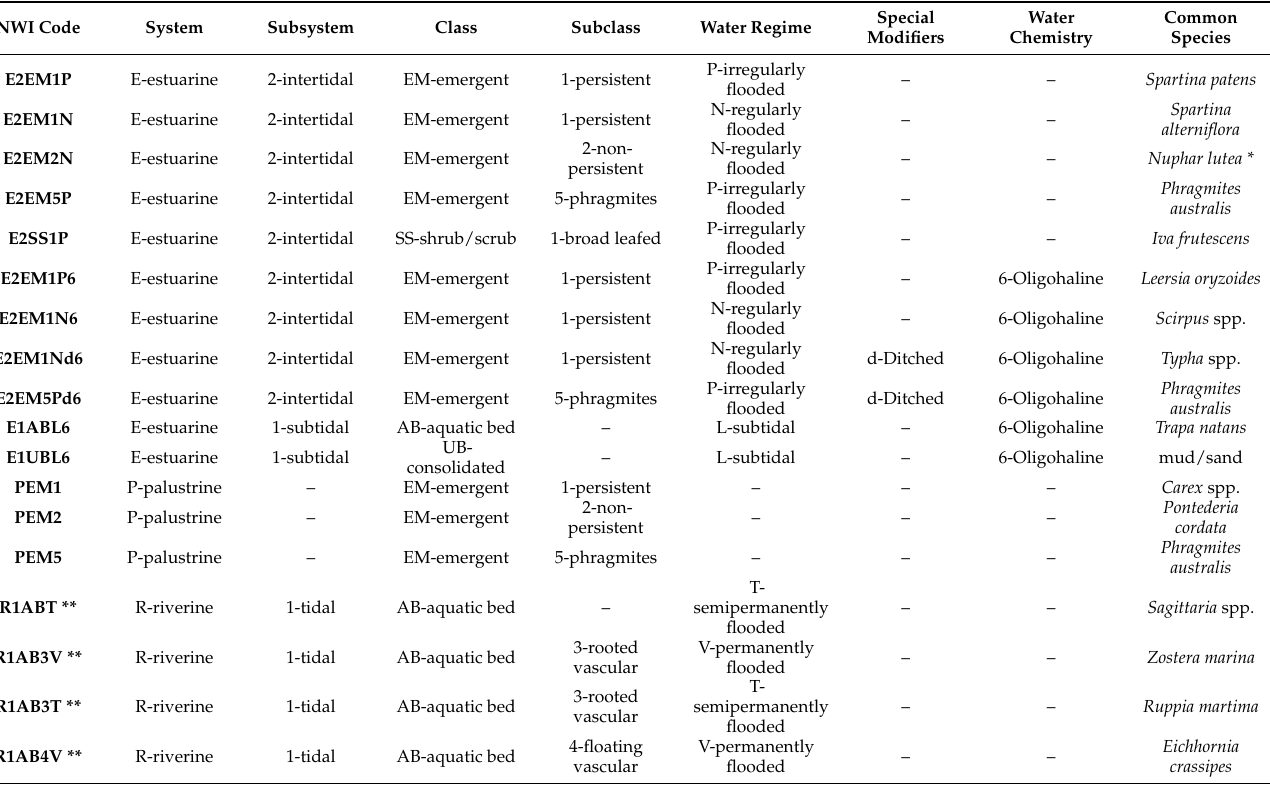
Table 1. NWI code definitions for common wetland and deepwater classes used in this study. The first column, NWI Code, is defined according to the Cowardin classification hierarchy in columns 2–8. Common species (right-most column) shows examples of vegetation common to a given NWI